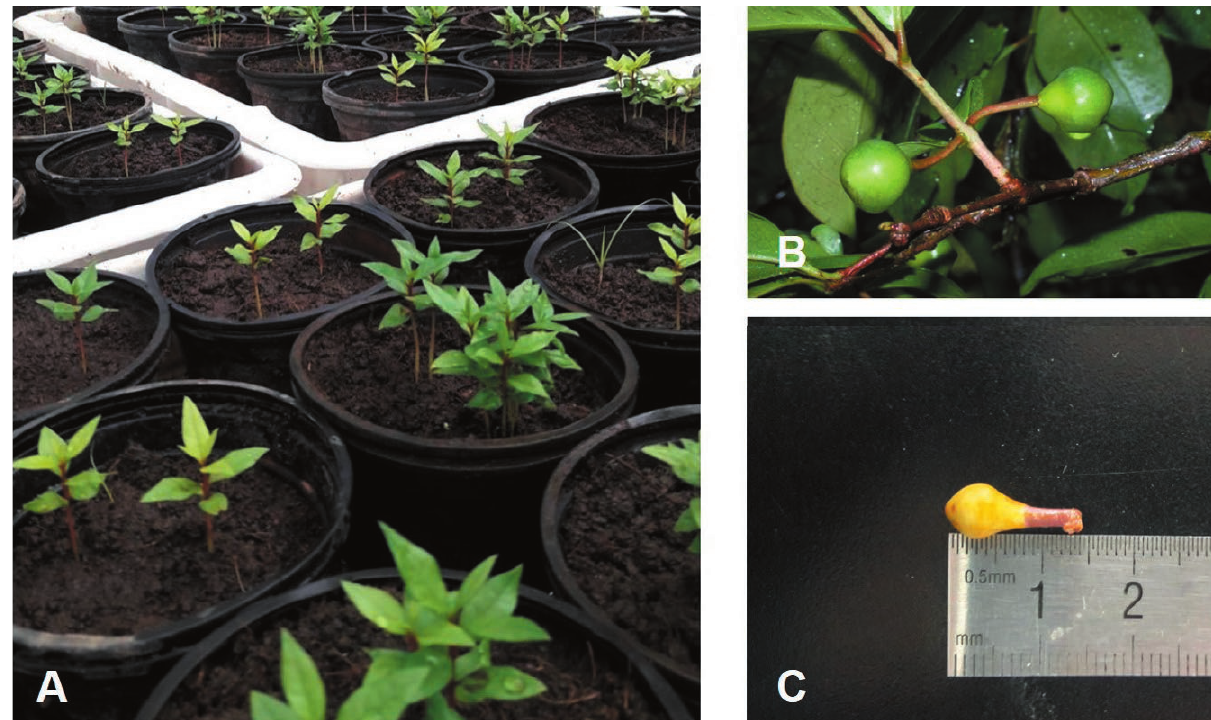
Figure 1. (a) Seedlings of P. friedrichsthalianum used to measure genome size by flow cytometry. (b and c) Flower buds of P. friedrichsthali- anum used for cytogenetic